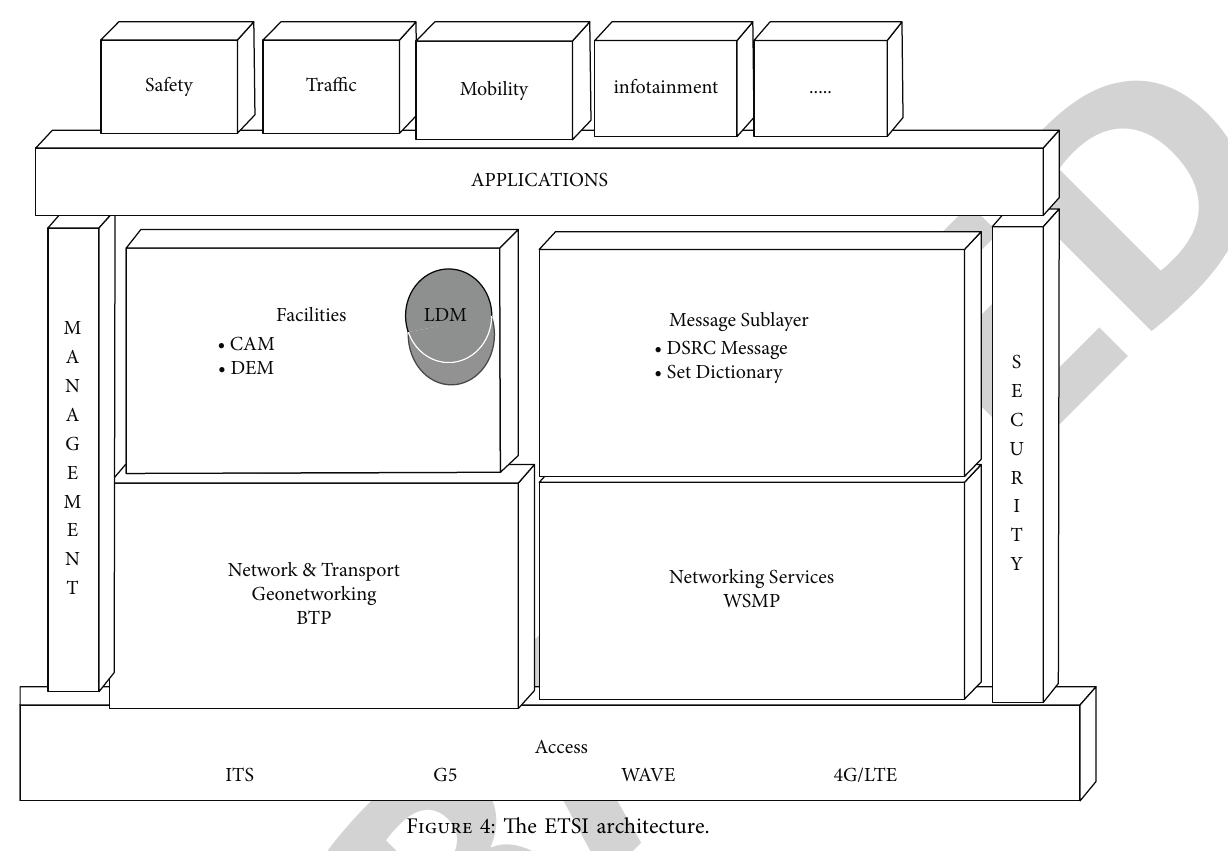
Figure 4: The ETSI architecture.